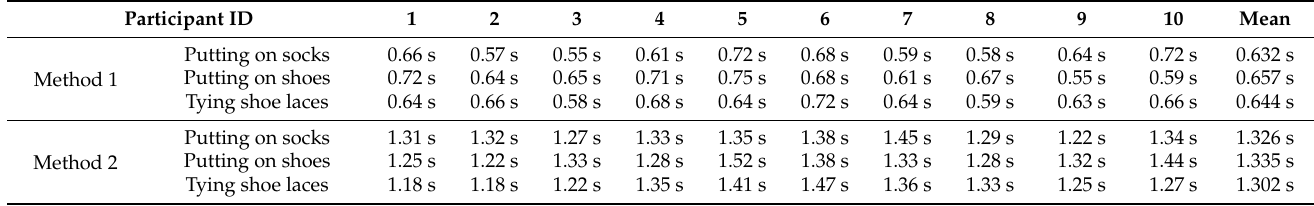
Table 6. Delay time generated by two control